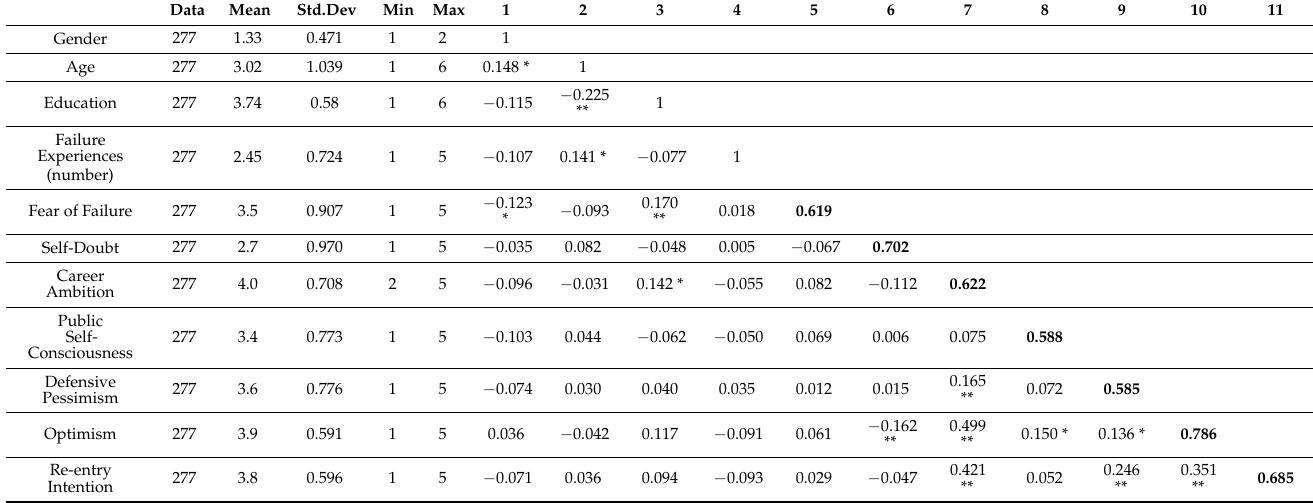
Table 4. Correlation results.